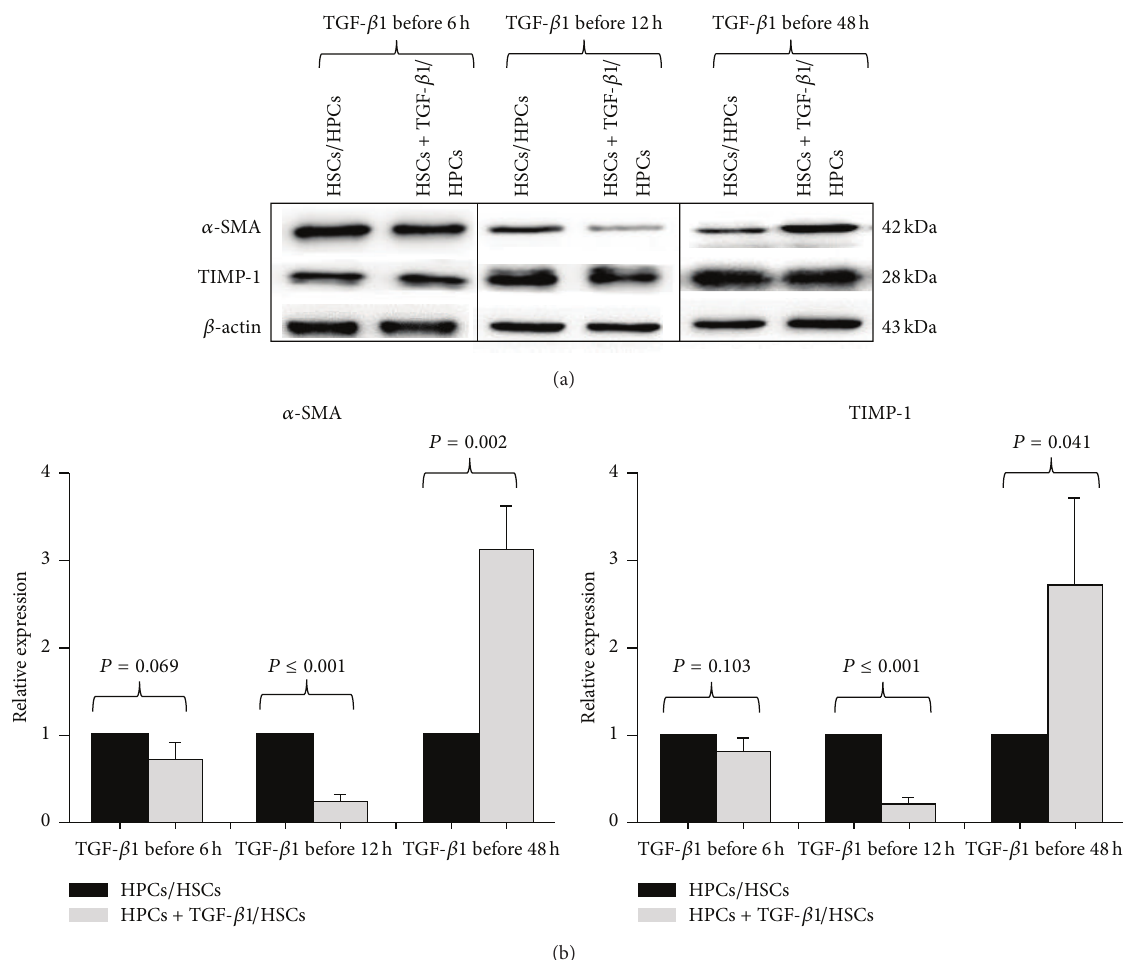
Figure 3: Influence of preexposure of HPCs to TGF- 𝛽 1 for different periods of time on the activation of HPCs. The expression levels of 𝛼 - SMA and TIMP-1 were measured by western blot (a). Quantification of the expression levels after normalization is shown in the lower panel (b). All data are expressed as the mean ± SD from three independent